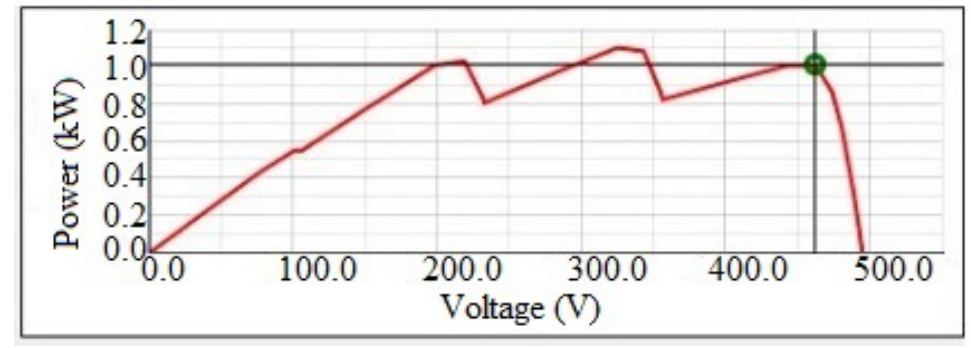
Figure 6. P-V curve for PS condition.